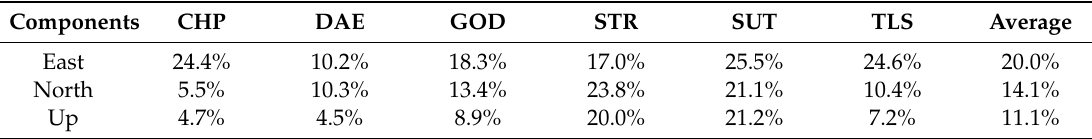
Figure 10. RMSs of ED Multi-GNSS ( top ) and FVUW Multi-GNSS ( bottom ) from DoY 201 to 230 in 2019. The average improved percentages of all baselines are presented in the right most column of Table 9, yielding comparable results to those of Table 8. At the bright side of this result, we can conclude that the positioning accuracies achieved by FVUW Multi-GNSS in the experiment extended by 30 days are as high as the improvements in the first 30 days. Specifically, the FVUW Multi-GNSS improved the positioning accuracy by more than 10% in all components, compared with ED Multi- GNSS.